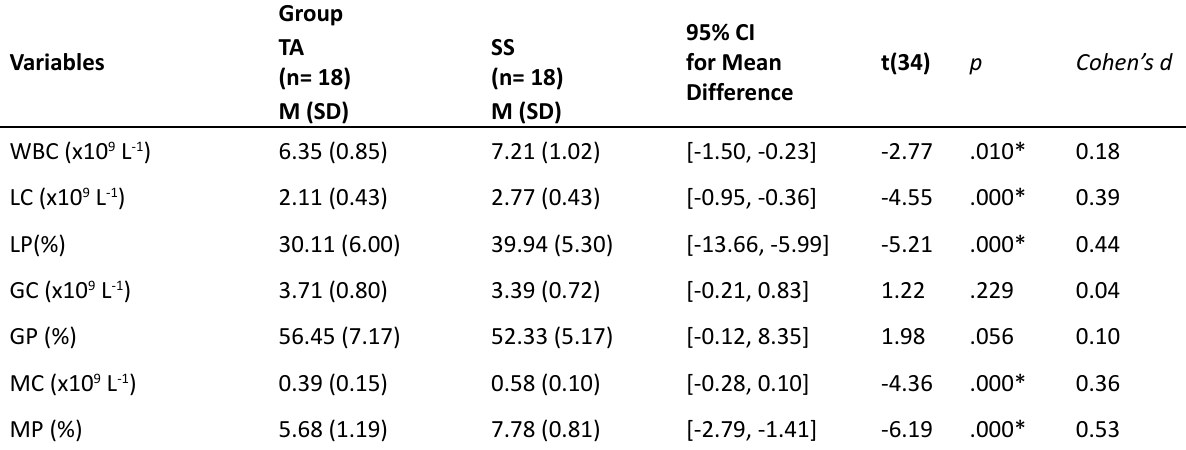
Table 2. Comparison of WBC parameters for TA and SS groups.